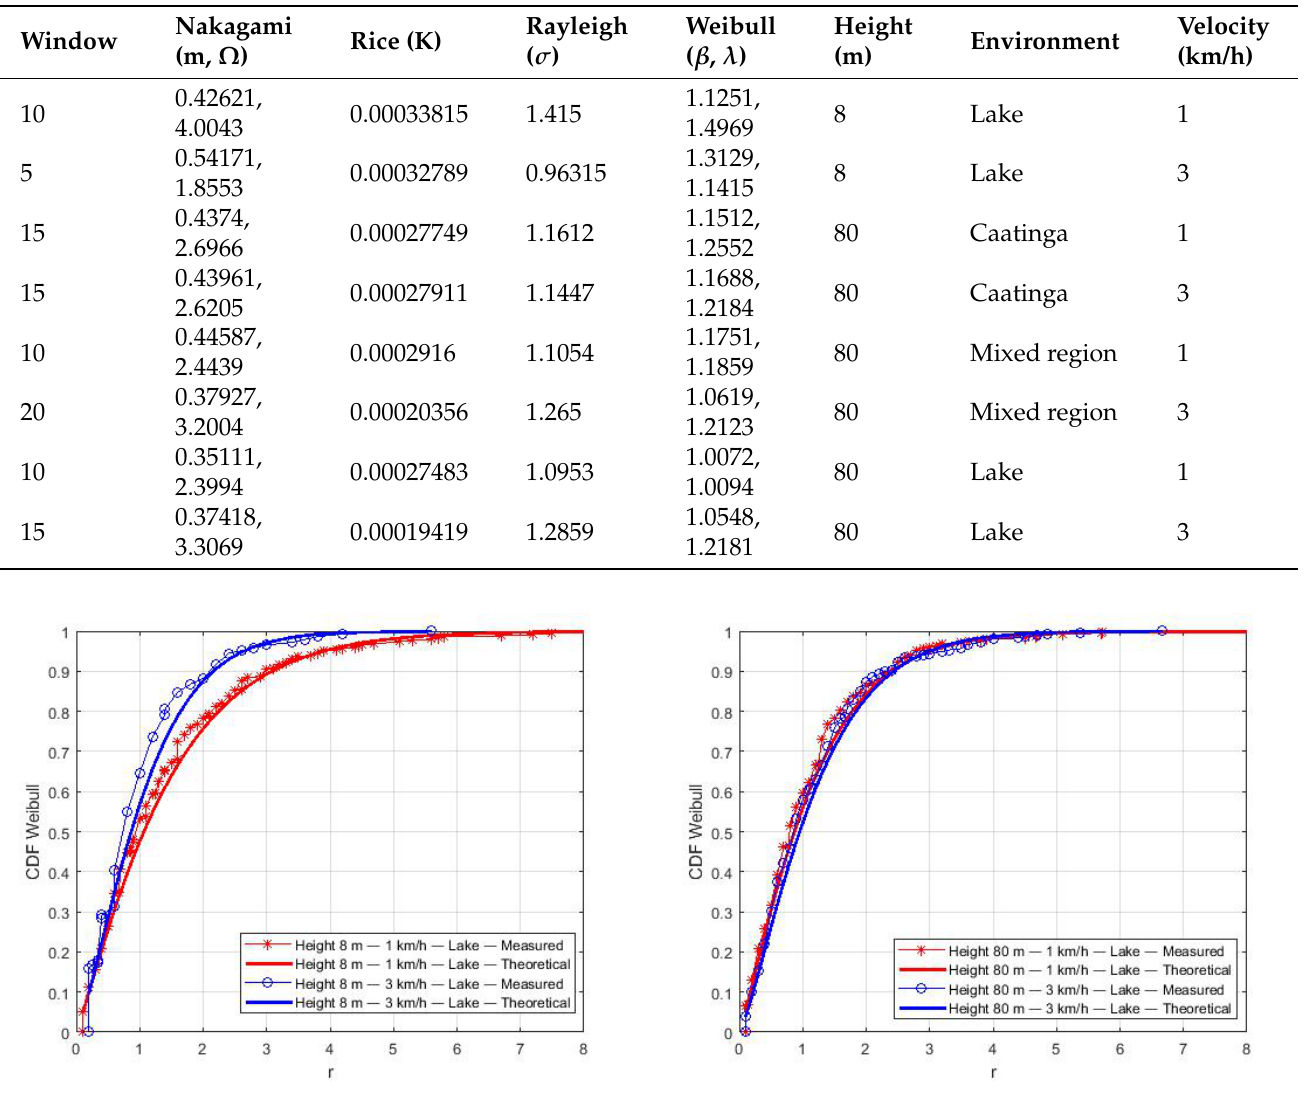
Table 8. Parameters of small-scale fading distributions for different environments.